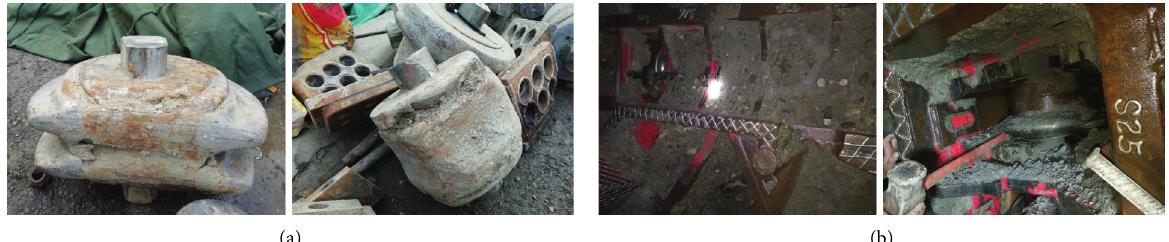
Figure 13: Excessive wear of the cutter tools and clogging of the cutter-head.